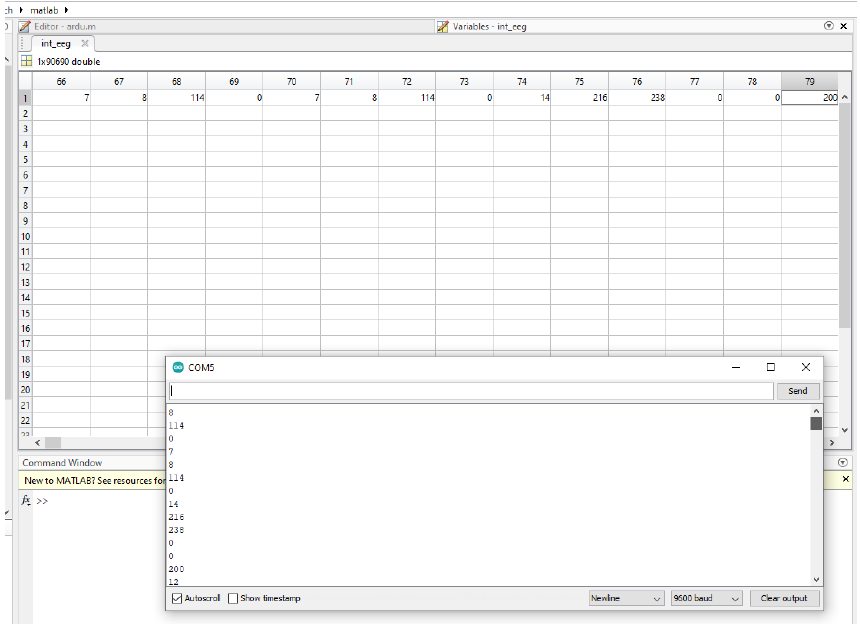
Figure 2. Evaluation of accurate EEG data transmission with Arduino. The values received by Arduino from the computer are identical to the values transmitted to the